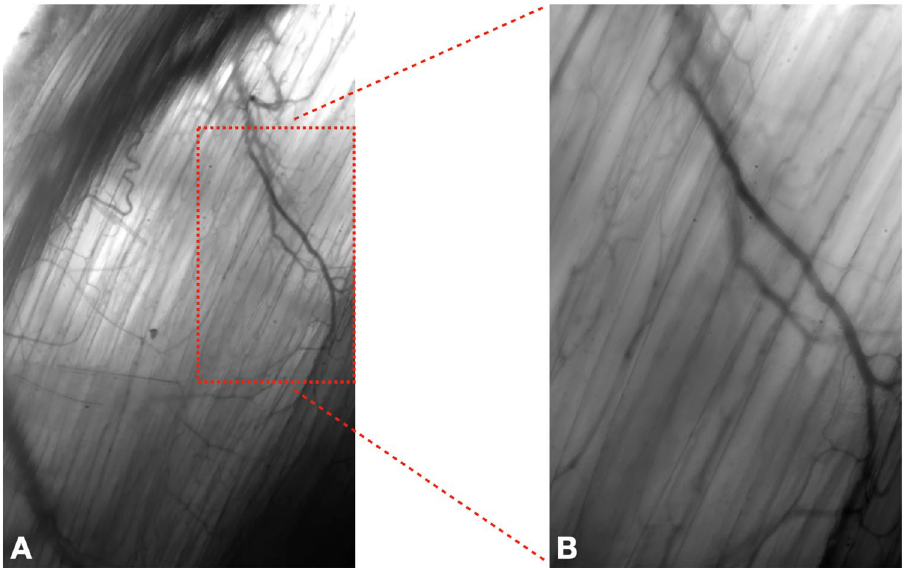
Figure 2. Video still images from IVVM observation of the EDL microvasculature. These images are acquired at baseline, before the start of the HD procedure. The cut-out in ( A ) represents a part of the total field of view (233 µm × 373 µm) shown in ( B ) (93 µm × 149 µm) (see the associated videos in supplemental data: S1-Fig. 2A and S2-Fig. 2B)” (image produced by B(GH)